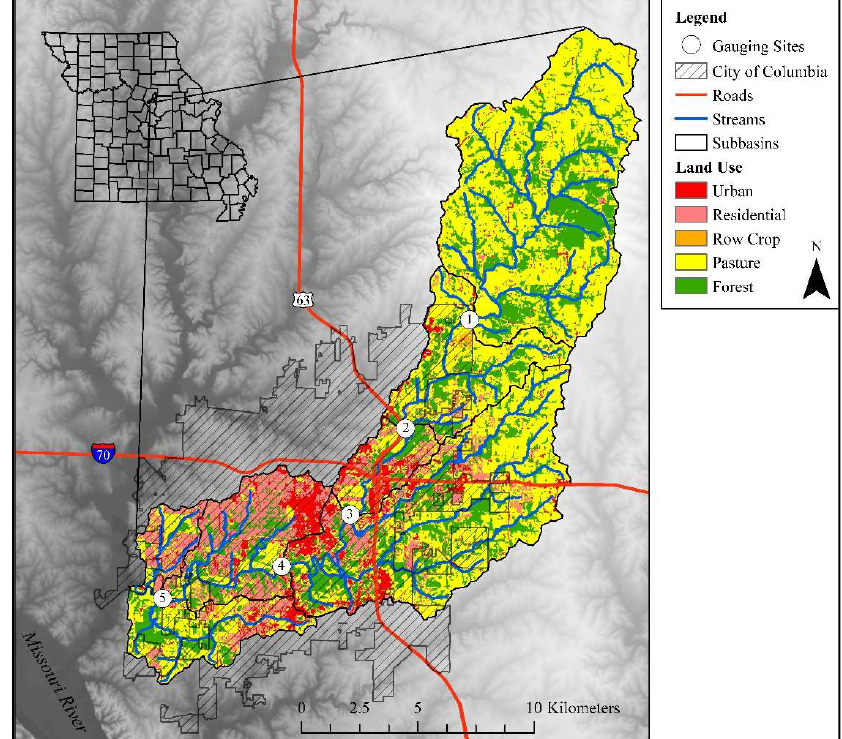
Figure 1. Nested-scale experimental watershed study design including five gauging sites located in Hinkson Creek watershed, Missouri, United States of America (USA).